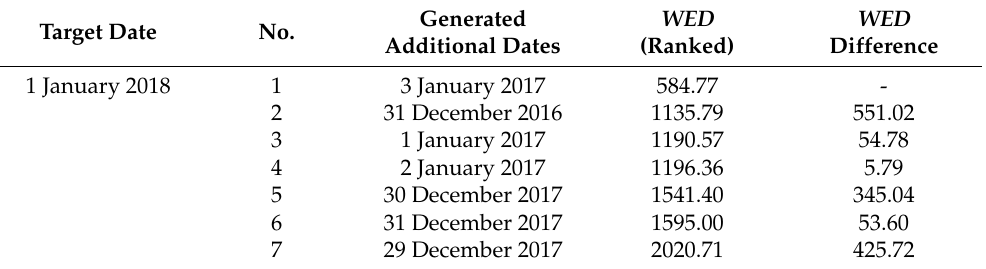
Table 2. Example of finding the largest jump in seven days.